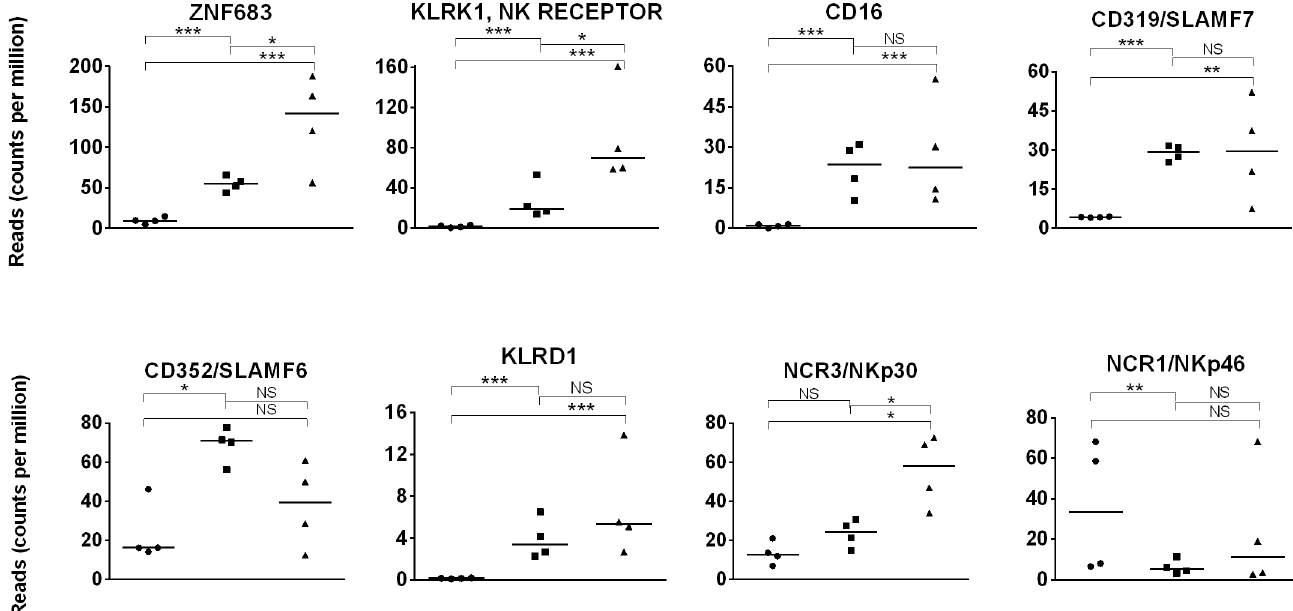
Fig 6. NK cell gene expression in day 1 foal, day 42 foal, and adult horse samples. Expression (quantified by number of reads on y-axis) of NK lineage genes in day 1 foal (circle), day 42 foal (square), and adult (triangle) samples are plotted on the x-axis. The significance level of comparisons is indicated by asterisks ( (cid:3) p < 0.05; (cid:3)(cid:3) p (cid:20) 0.001; (cid:3)(cid:3)(cid:3) p (cid:20) 0.0001); comparisons that did not differ statistically are labeled “NS” to denote not